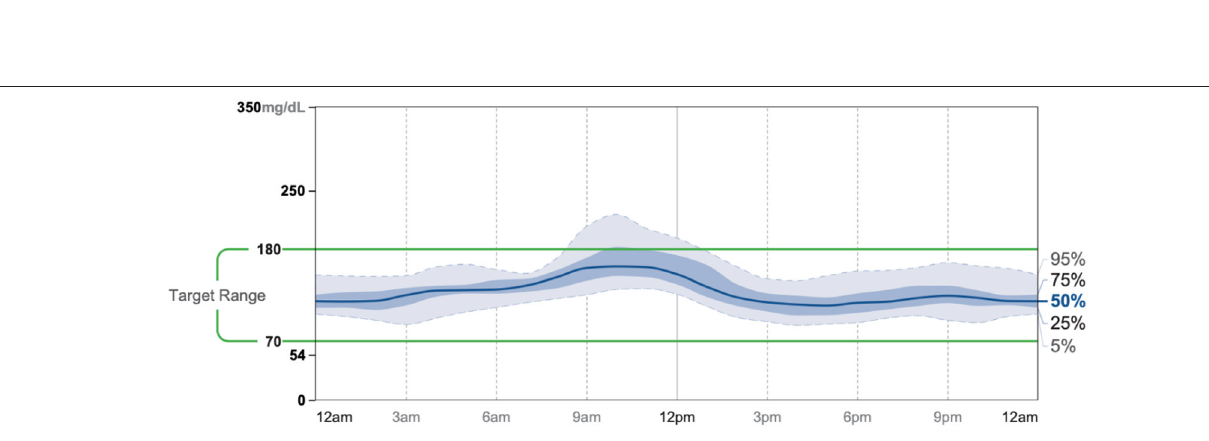
FIGURE 3 | Lab values of Patient #1 at the start and the end of the program. * Sample was hemolyzed.